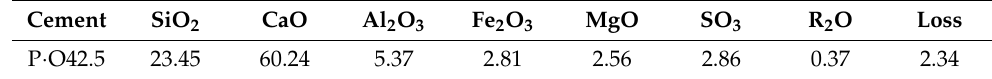
Table 3. Chemical composition of cement (w/%).